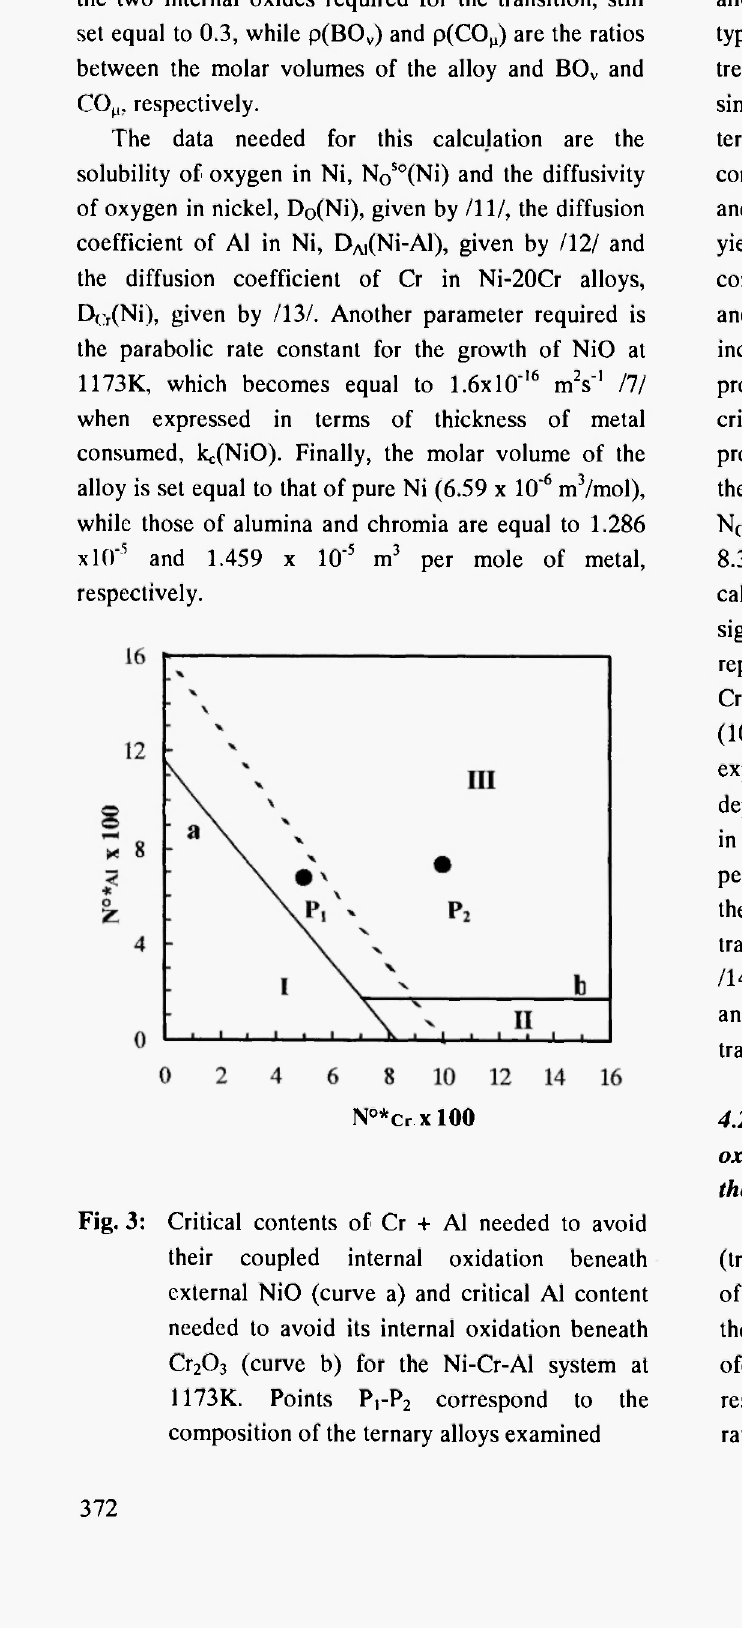
Fig. 3: Critical contents of Cr + Al needed to avoid their coupled internal oxidation beneath external NiO (curve a) and critical Al content needed to avoid its internal oxidation beneath Cr 2 0 3 (curve b) for the Ni-Cr-Al system at 1173K. Points Pi-P 2 correspond